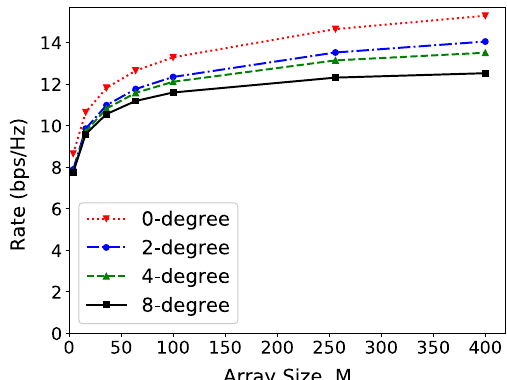
Fig. 9 Beamforming rate with approximated downlink channel changing with base-station array size. The plot is based on simulated channels with different angle spreads